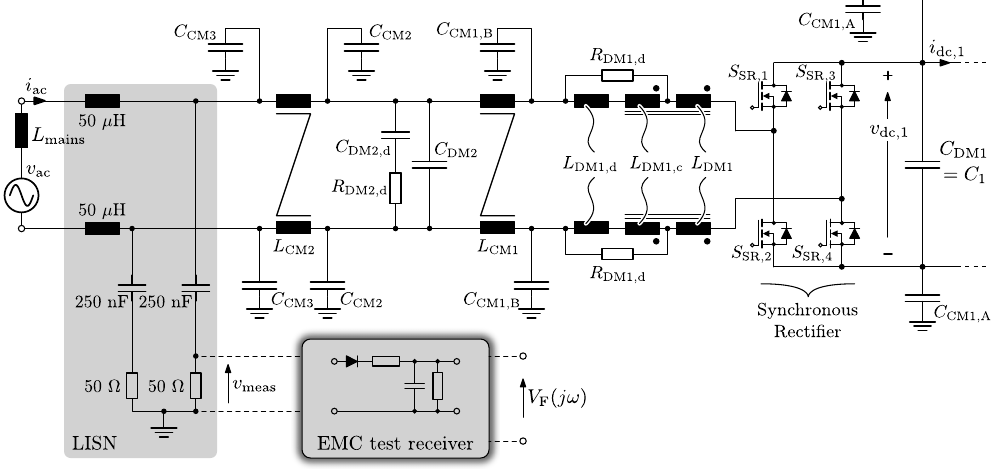
Figure 15. Schematic of the differential mode/common mode (DM/CM) electromagnetic compatibility (EMC) filters, connected to the synchronous rectifier of the ac-dc converter. Also shown are the line impedance stabilization network (LISN) and the EMC test receiver.